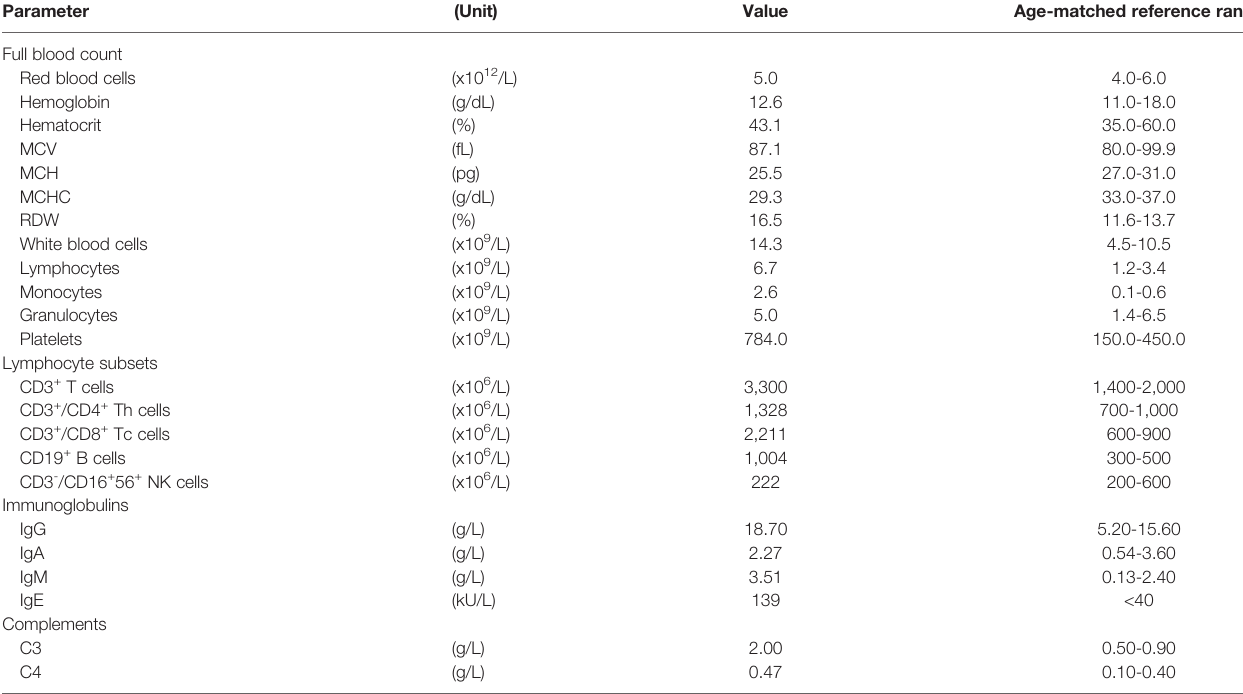
TABLE 1 | Blood test results of the patient. Parameter